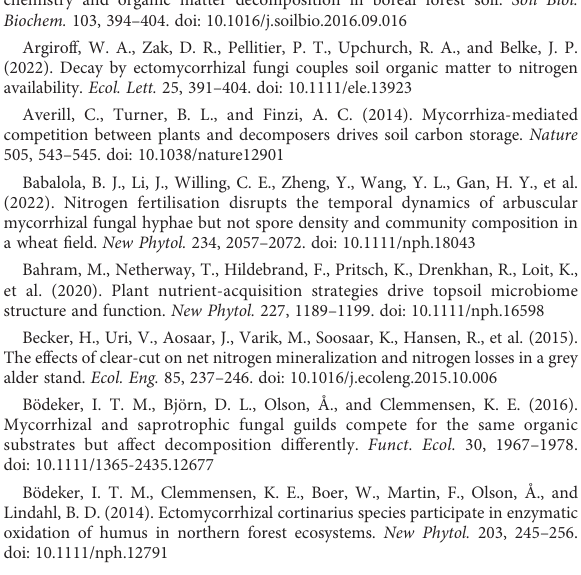
SUPPLEMENTARY FIGURE 1 Rarefaction curve showing the sequence depth and observed OTUs. Note: EcM forest, Abies fargesii var. faxoniana primary forest; AM forest, Cupressuschengiana primary forest; ErM forest, Rhododendron phaeochrysum primary forest; -5, -7 and -11 represented May, July and November respectively. SUPPLEMENTARY FIGURE 2 Correlations between the difference in soil net N mineralization rate, biological and abiotic factors. Note: PEX, peroxidase; POX, phenol oxidase; T, temperature; WFPS, water- fi lled pore space; AM fungi, arbuscular mycorrhizal fungi; EcM fungi, ectomycorrhizal fungi; ErM fungi, ericoid mycorrhizal fungi; SAP, unde fi ned saprotroph; ‘ Others ’ include endophyte and lichenized. Pathotrophs include animal pathogen, plant pathogen and mycoparasites; Net R a , net ammoni fi cation rate; Net R n , net nitri fi cation rate; **, P < 0.01; *, P < 0.05; not signi fi cant (ns), P >